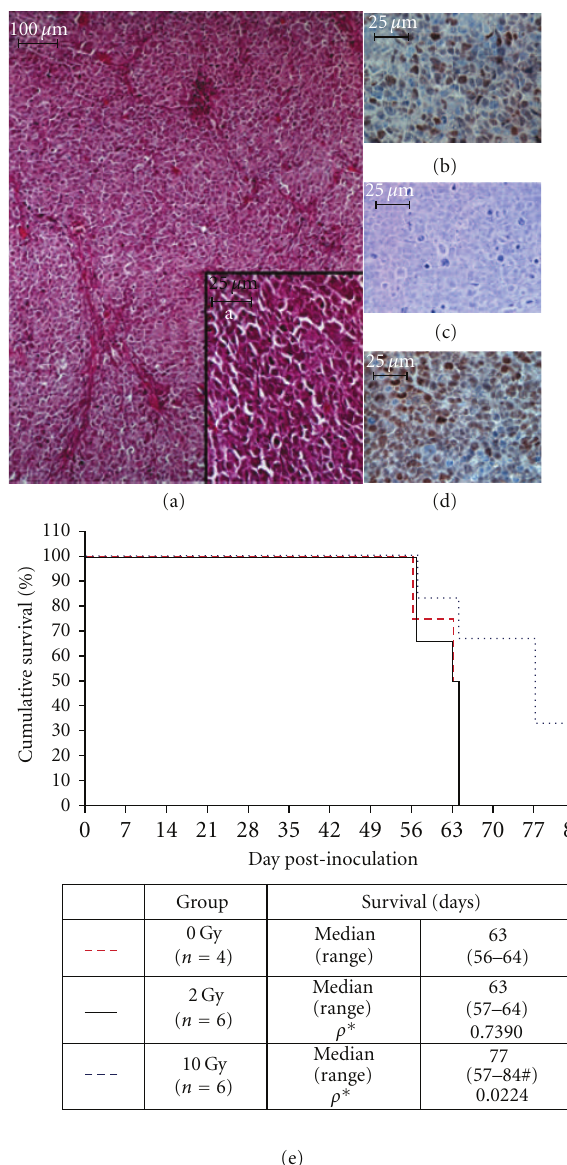
Figure 4: Representative histology and immunohistochemistry of RC13-luc derived metastatic lesion. (a)H&E, 10x, and (a)40x; (b) MyoD1; (c) IHC neg. control; (d) Myogenin. (e) Cumulative survival. Kaplan-Meier plot of survival in tumor-bearing mice following localized irradiation with 2Gy (solid black) or 10Gy X-rays (dotted blue), or 0Gy, sham-irradiated